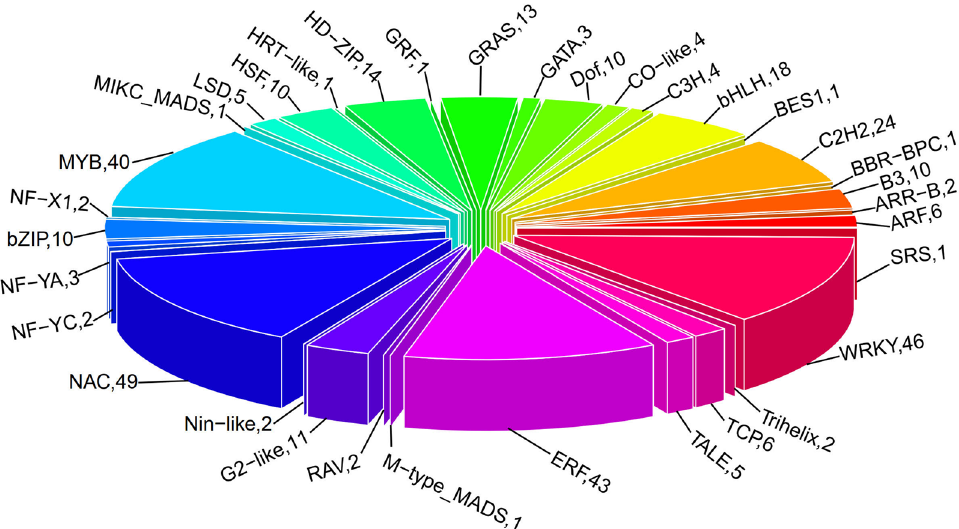
Figure 8. Annotation of transcription factors of specific DEGs under Na 2 SO 4 stress created by plotrix (v3.8.1).